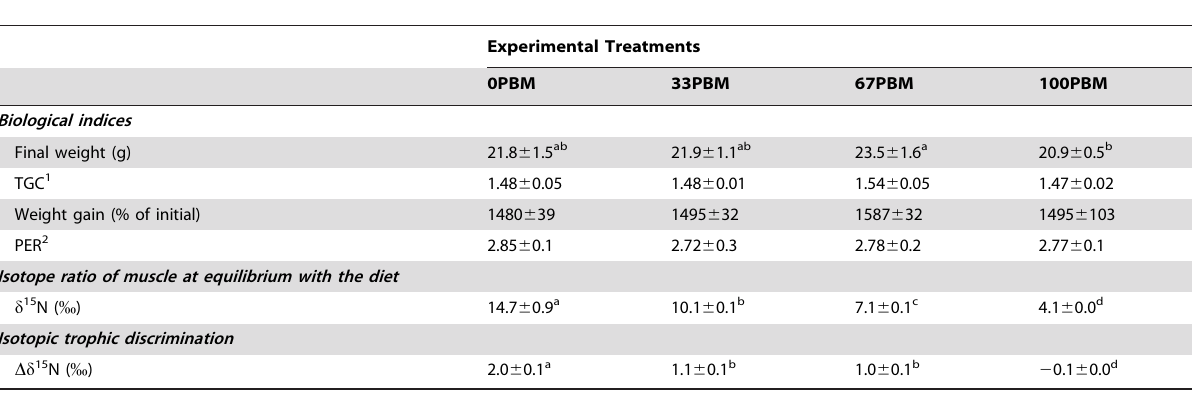
Table 2. Biological indices, nitrogen isotope ratios ( d 15 N) of muscle tissue and trophic discrimination values for juvenile rainbow trout ( Oncorhynchus mykiss ) fed four experimental diets formulated to contain similar protein and lipid levels.